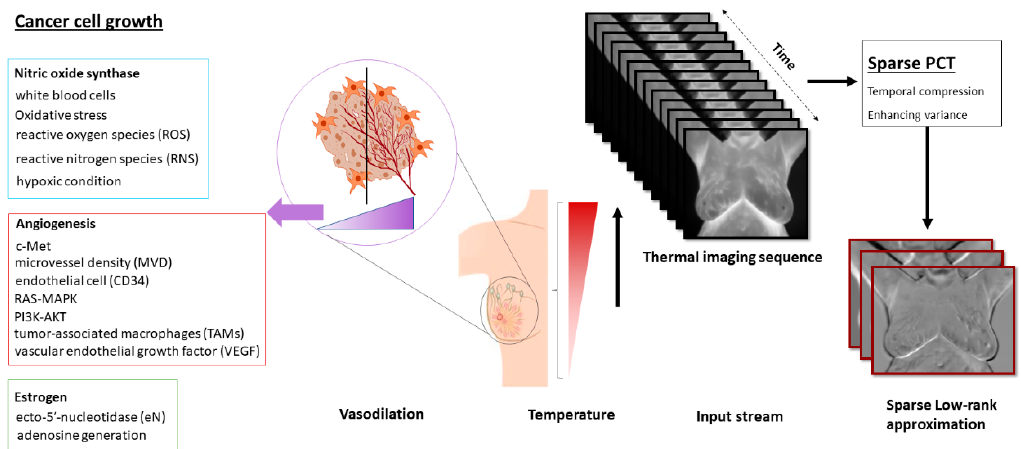
Figure 1. The block diagram of the biological connection to the response of infrared thermography as a fast step with other methods such as clinical breast exam (CBE) in breast cancer screening and cancer presence in the breast area are shown.